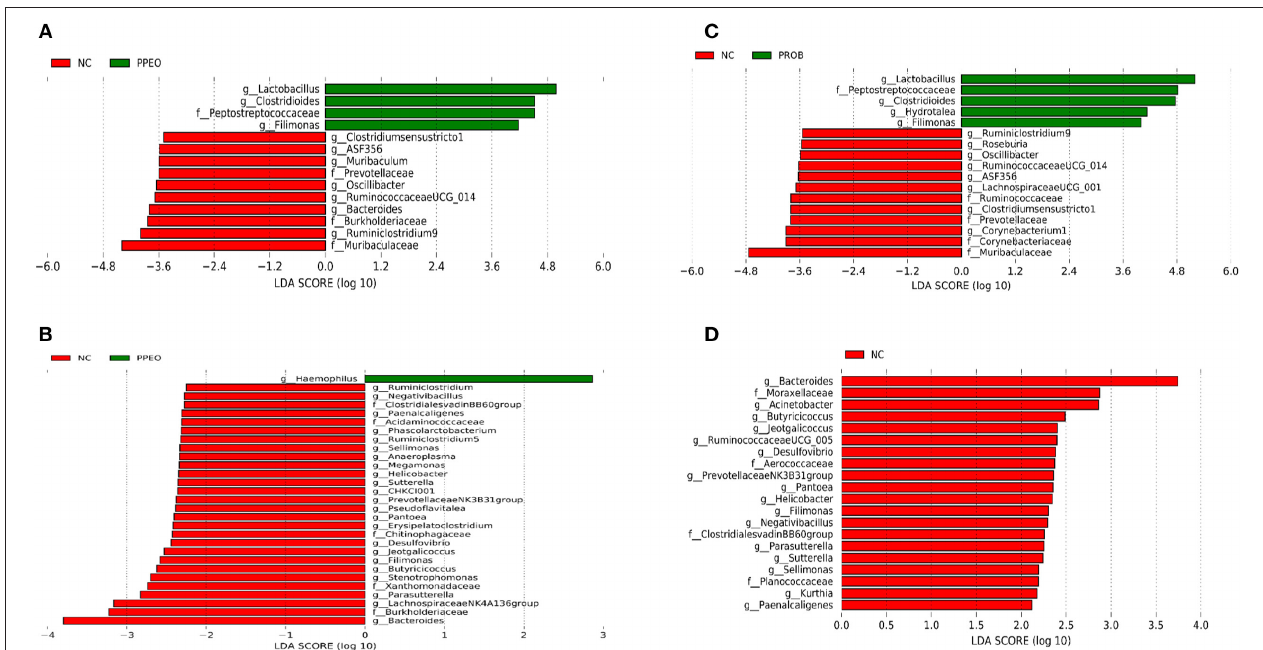
FIGURE 4 | Taxonomic biomarkers highlighted by linear discriminant analysis effect size (LEfSE) ( P ≤ 0.05 and LDA cutoff > 2.0) in ileal mucosa microbiota of broiler chickens challenged with a subclinical naturally occurring necrotic enteritis ( n = 8/treatment). (A,B) Taxonomic biomarkers in NC vs. PPEO group on d 8 and d 42, respectively. (C,D) Taxonomic biomarkers in NC vs. PROB group on d 8 and d 42, respectively. NC (negative control): corn-soybean meal basal diet; PPEO (probiotic/prebiotic/essential oil supplement): NC + 453 g/ton of a supplement containing B. licheniformis spores, mannan-oligosaccharides, β -glucans (1,3 and 1,6), capsaicin, and curcuma; PROB (Probiotic): NC + 227g B. licheniformis spores/ton diet.